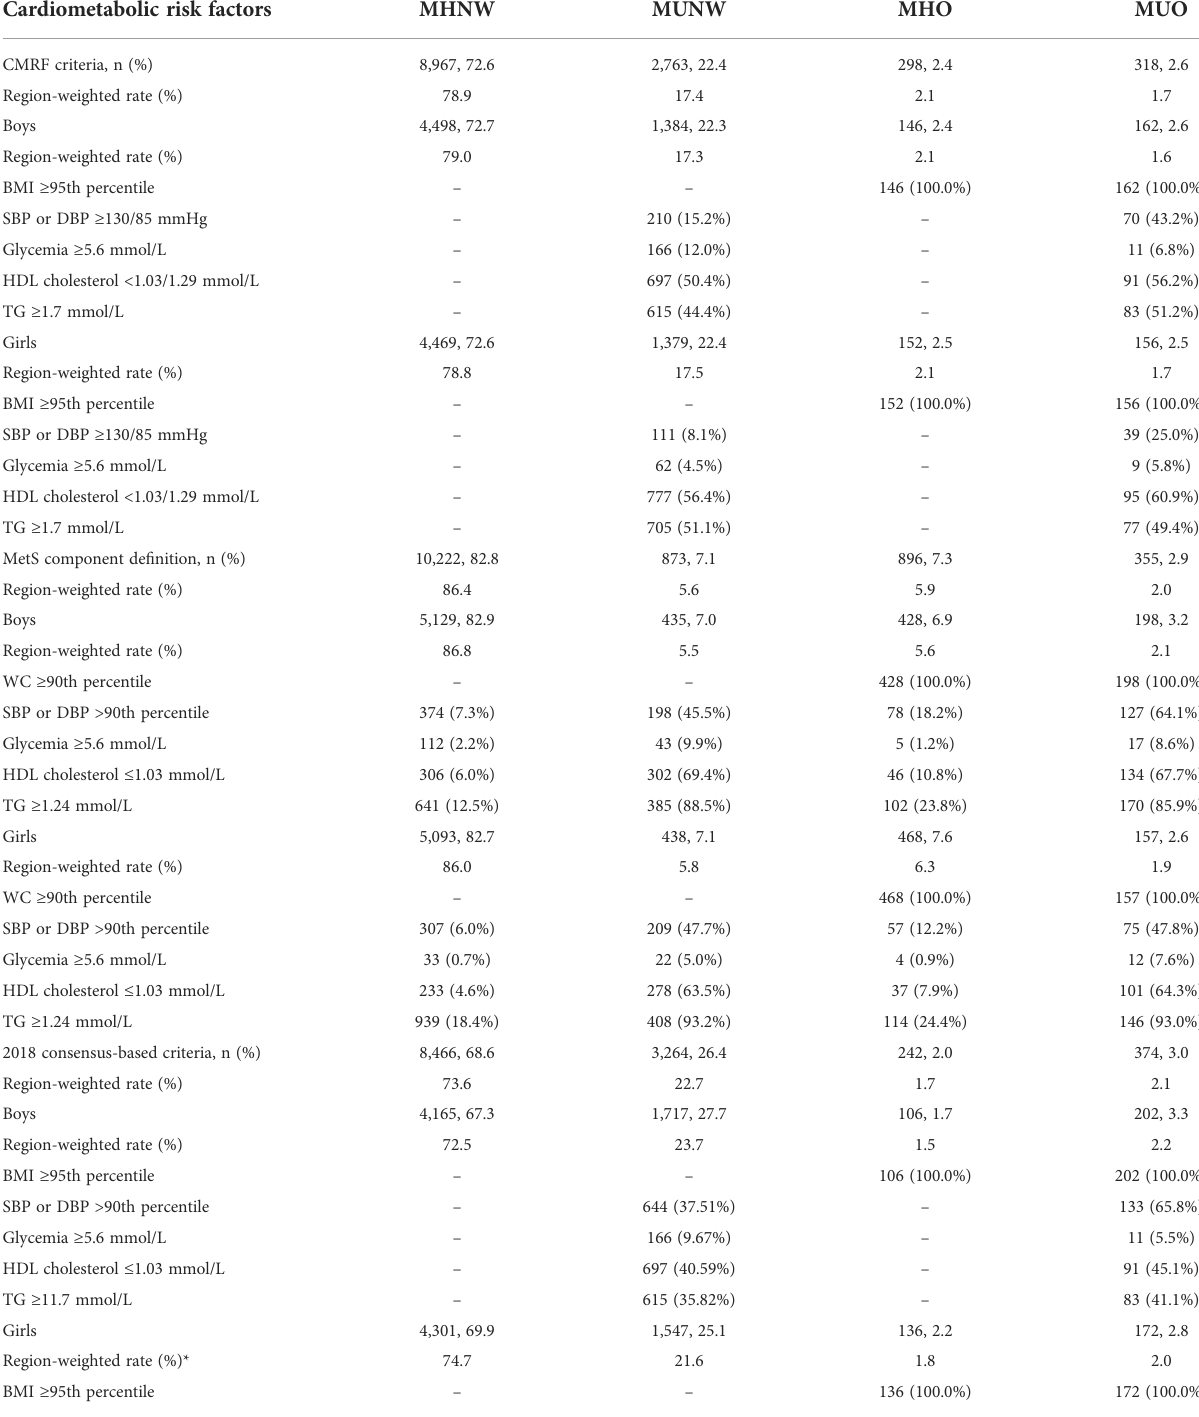
TABLE 3 Distribution of cardiometabolic risk factors among different metabolic body size phenotypes in each sex, based on three widely used de fi nitions. Cardiometabolic risk